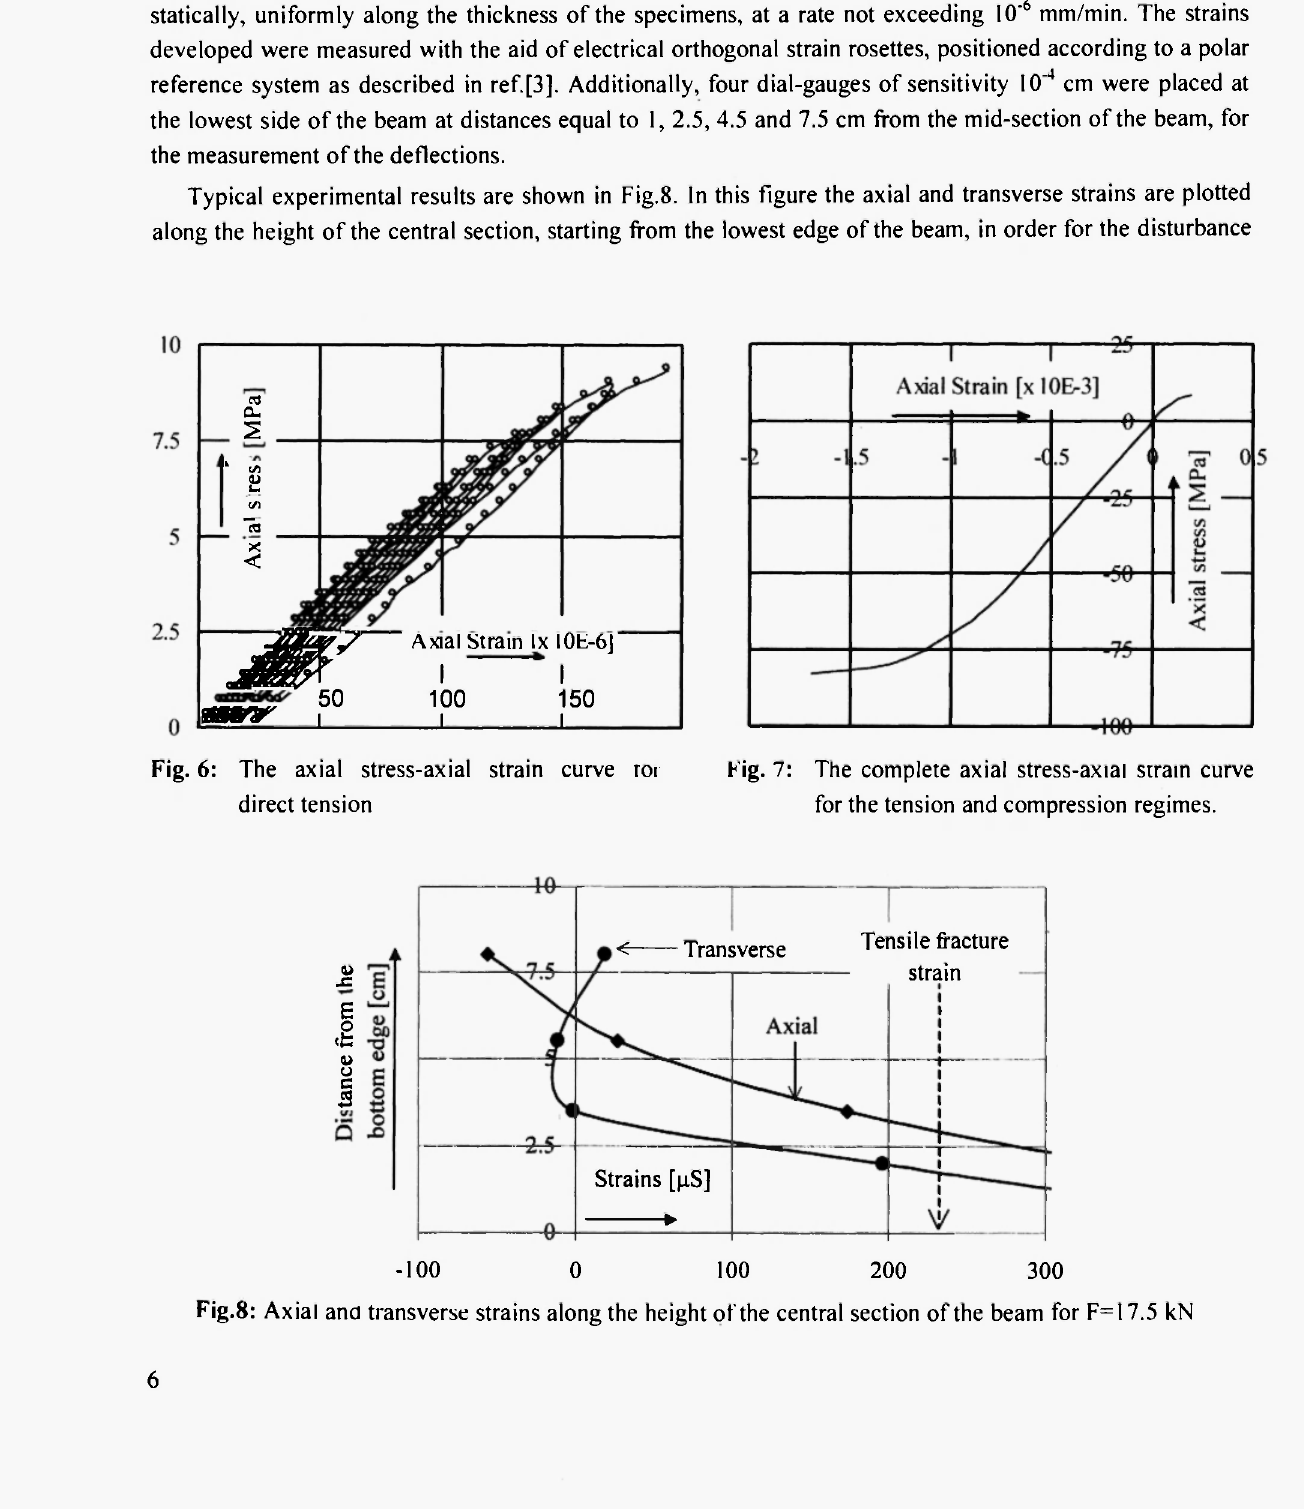
< Transverse Tensile fracture